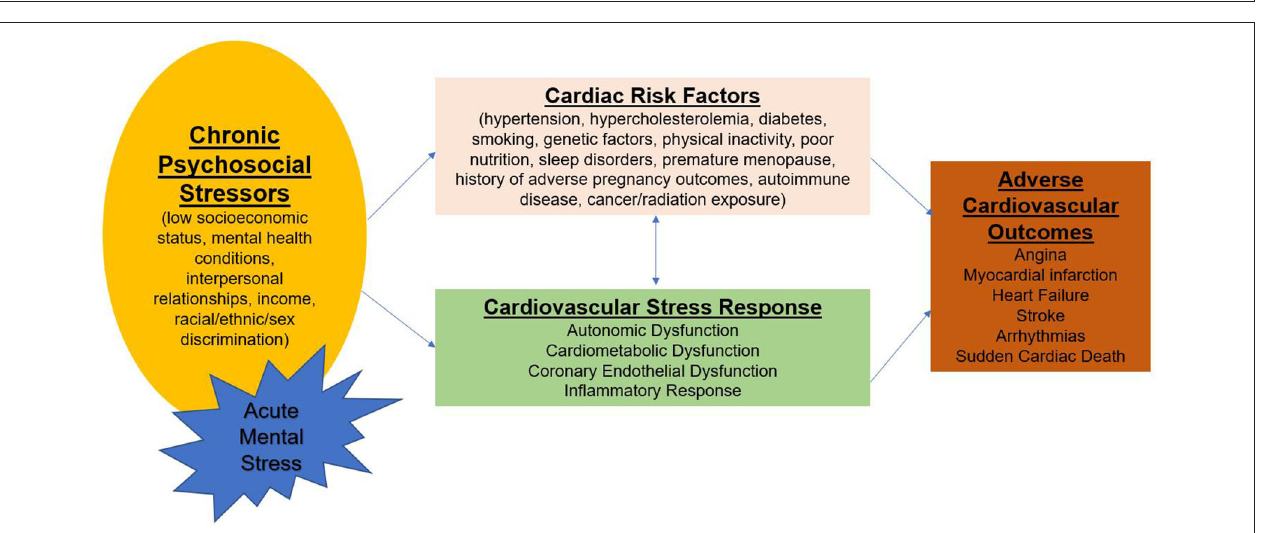
FIGURE 1 | Prevalence of “Normal” and non-obstructive coronary arteries in women and men. Normal (no visible angiographic disease) or non-obstructive coronary arteries (luminal irregularities < 50%) is found more often in women than men who undergo invasive coronary angiography for acute coronary syndrome and ST-segment elevation myocardial infarction. Reprinted with permission ( 14).